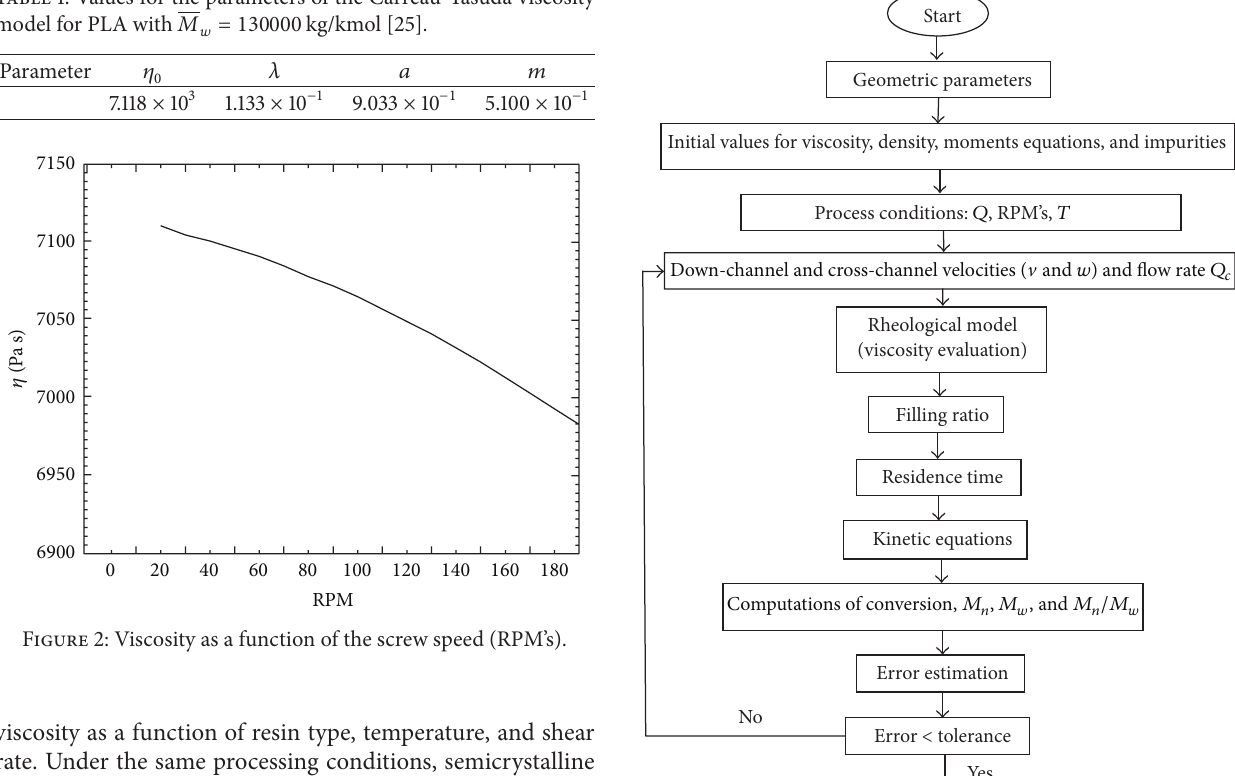
viscosity as a function of resin type, temperature, and shear rate. Under the same processing conditions, semicrystalline PLA had a higher shear viscosity than the amorphous one.